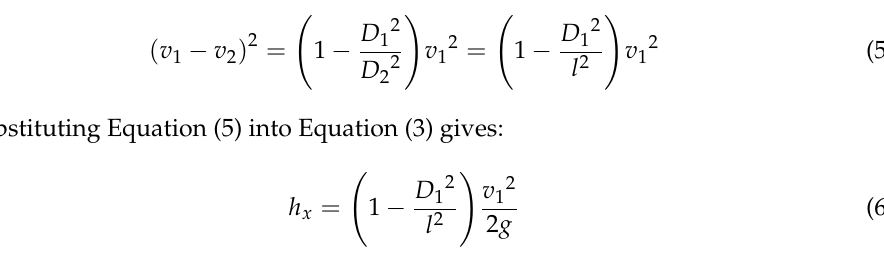
Figure 3. The flow rate curve at the outlet with a 2 mm compressible cavity at the inlet and an in- compressible cavity at the outlet. The conclusions drawn from this simulation study were that: (1) when changing the height of the fluid chamber with constant inlet and outlet pressure, the flow at the outlet of the 2 mm compressible chamber and the incompressible chamber decreases with the increase of the height of the fluid chamber, (2) the flow output of the piezoelectric pump with a compressible cavity is significantly higher than that of a piezoelectric pump without a compressible cavity; and (3) the lower the height of the compressible cavity, the greater the flow output of the piezoelectric pump. 5. Experimental Studies The layout of the prototype pump and the as-constructed device are shown in Fig- ures 4 and 5, respectively. The main components of the prototype pump are the pump body, the wheel valve plate, the valve plate cover, the piezoelectric vibrator, the vibrator diaphragm, and the metal wire welded on the vibrator. The instruments, components, and materials used in the experimental set-up are shown in Figure 5. The principal ele-